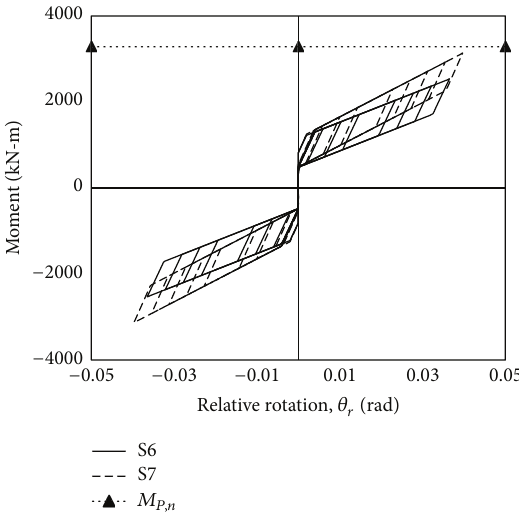
Figure 12: Moment-relative rotation response S6 and